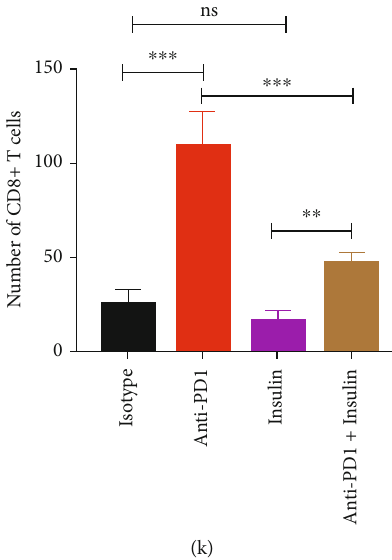
Figure 6: Insulin promotes colon tumor growth and weakens tumor immune responses to anti-PD1. (a) Schematic overview of experimental design combined for (b) – (k). (b – d) Tumor growth (b) and weight (c) from MC38 tumor-bearing C57BL/6 mice were shown ( n = 7 ). (e – g) Tumor growth (e) and weight (g) from CT26 tumor-bearing on BABL/C mice were shown ( n = 7 ). (h and i) Sections from MC38 subcutaneous tumors were stained with anti-CD8 antibody by immunohistochemistry (h) and CD8 + T cells in fi ltration were analyzed in (i). (j and k) Sections from CT26 subcutaneous tumors were stained with anti-CD8 antibody by immunohistochemistry (j), and CD8 + T cells in fi ltration were analyzed in (k). Scale bars: 100 μ m. Data were analyzed by two-way ANOVA (b and e) and t -test (c, f, i, and k). ns: no signi fi cance; ∗ p < 0 : 05 , ∗∗ p < 0 : 01 , and ∗∗∗ p < 0 : 001 . Error bars denote for the